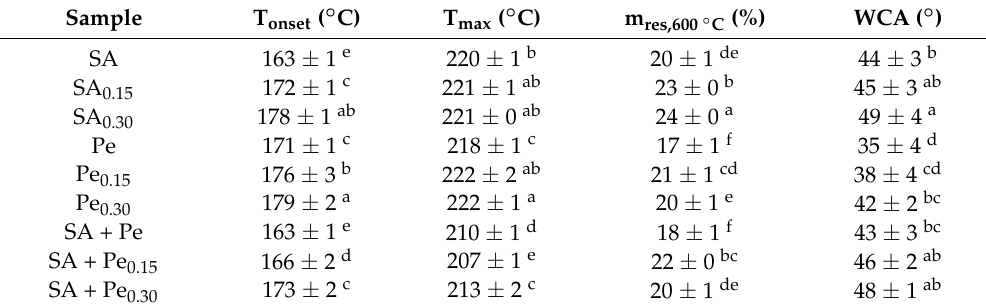
Table 4. Thermogravimetric and wettability data of Sa, Pe and SA + Pe